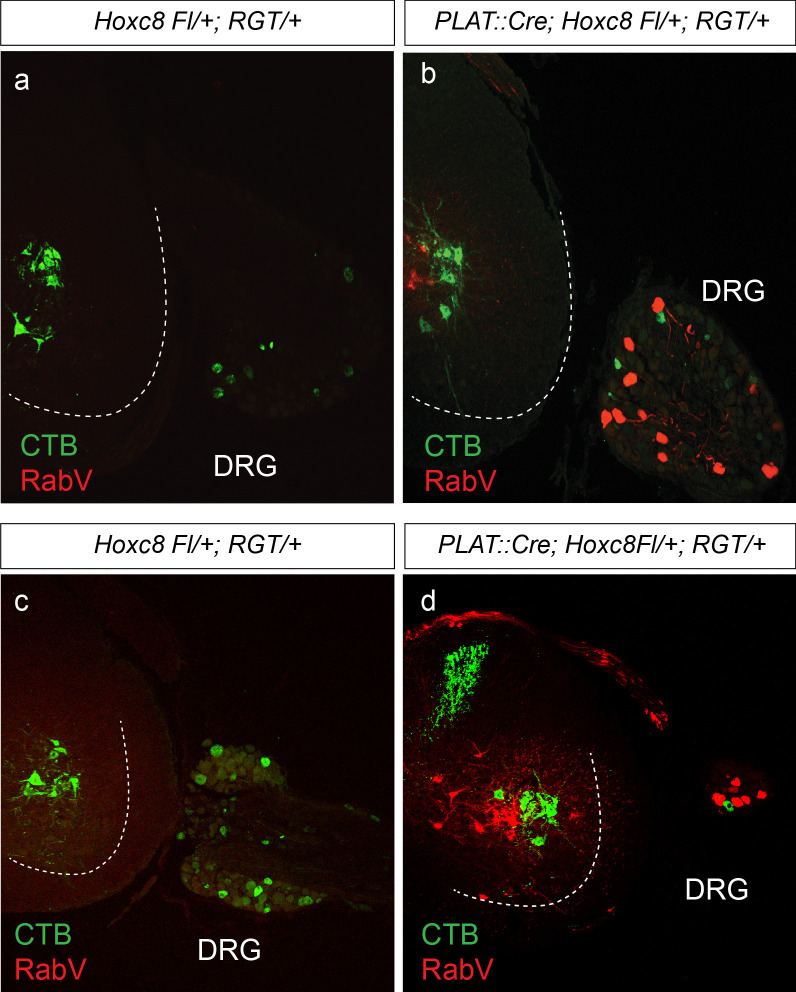
Cre-dependent rabies infection of sensory neurons.(a–d) Cross sections of spinal cord with adjacent DRG in caudal cervical region of P12 mice. RV∆G-mCherry-EnvA injected into FCU muscle with concurrent injection of CTB in ECR/ED. No mCherry was detectable in SNs or MNs of Cre- mice (a, c). RV∆G-mCherry-EnvA injected into FCU of Cre+
Hoxc8LacZ-flox/+ mice exhibited mCherry expression in predominately large diameter SNs, INs, and MNs in the ipsilateral ventral spinal cord (b, d).